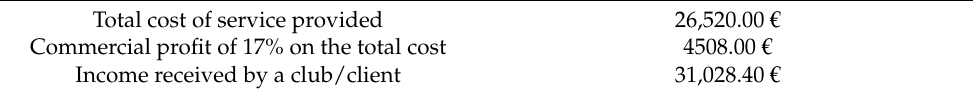
Table 13. Estimated income obtained from each service received and profit obtained on each service.